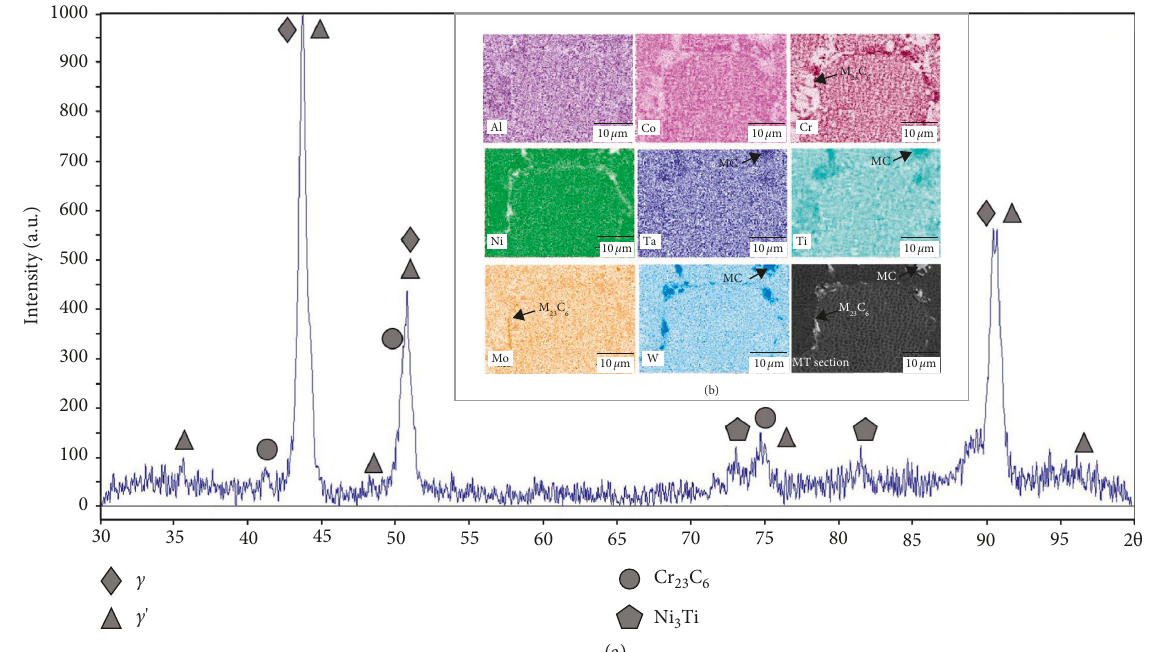
Figure 11: Characterization of the IN-792 superalloy. MT section by (a) XRD pattern and (b) element-imaging SEM